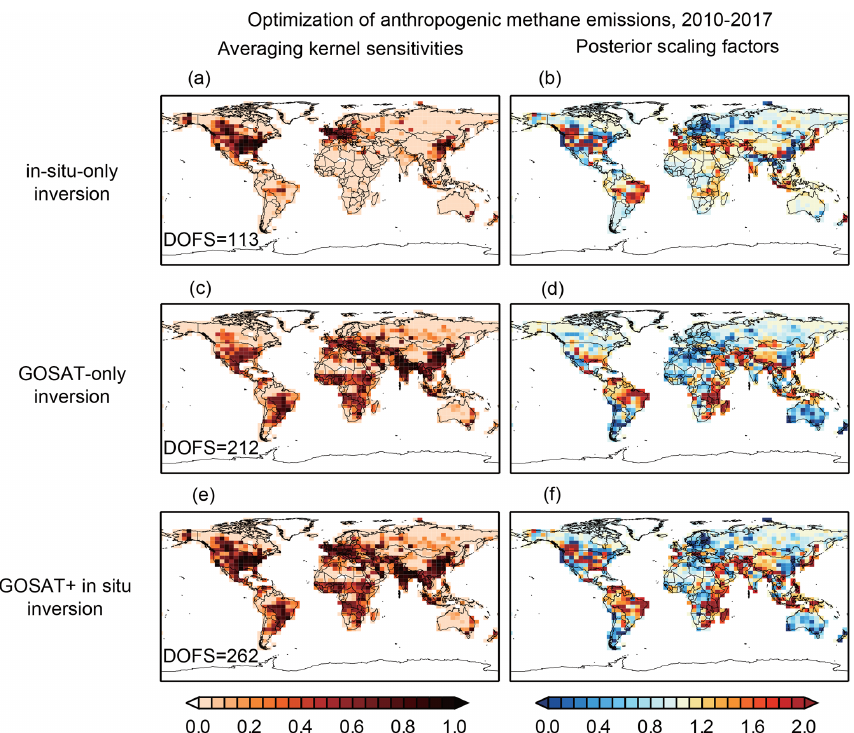
Figure 8. Optimization of mean 2010–2017 non-wetland (mainly anthropogenic) emissions. The in-situ-only inversion uses in situ observa- tions, the GOSAT-only inversion uses GOSAT satellite observations, and the GOSAT + in situ inversion uses both. Panels (a) , (c) , and (e) show the averaging kernel sensitivities (diagonal elements of the averaging kernel matrix) for each inversion, with the degrees of freedom for signal (DOFS, defined as the trace of the averaging kernel matrix) given inset. Panels (b) , (d) , and (f) show the correction factors to the prior emissions (Fig. 3a). Wetland emissions are corrected separately (see text). Table 2. Anthropogenic methane emissions and trends, 2010–2017 a